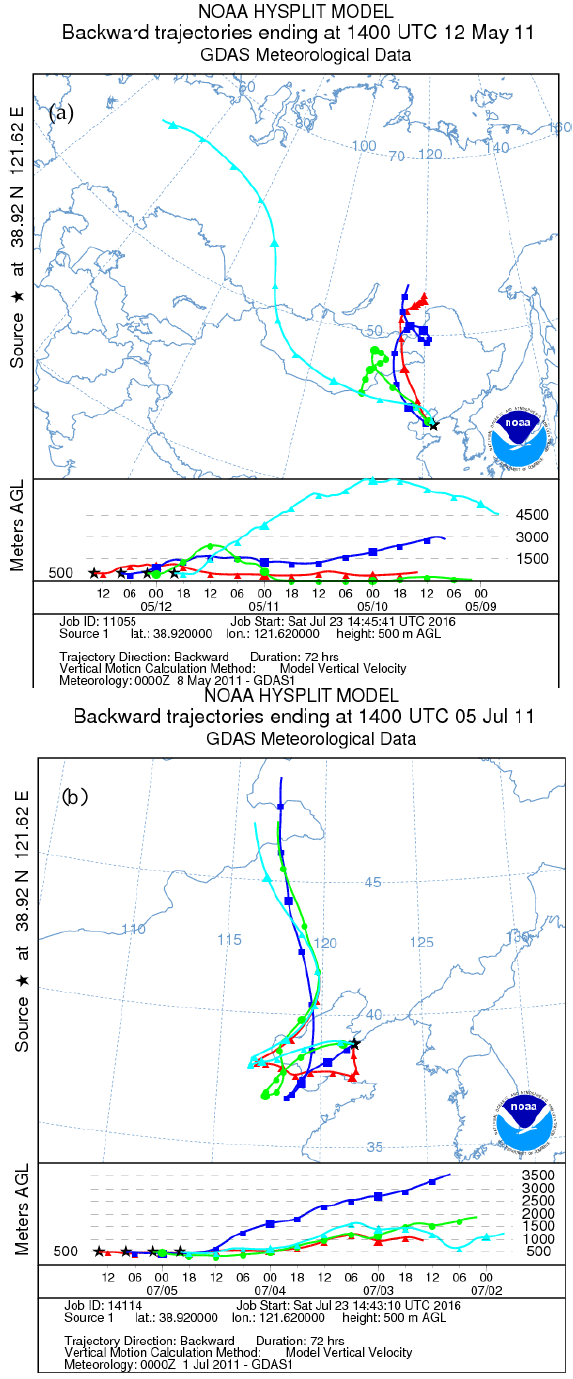
Figure 10. HYSPLIT back-trajectories on Dalian monitoring station for ( a ) dust and ( b ) fog events.